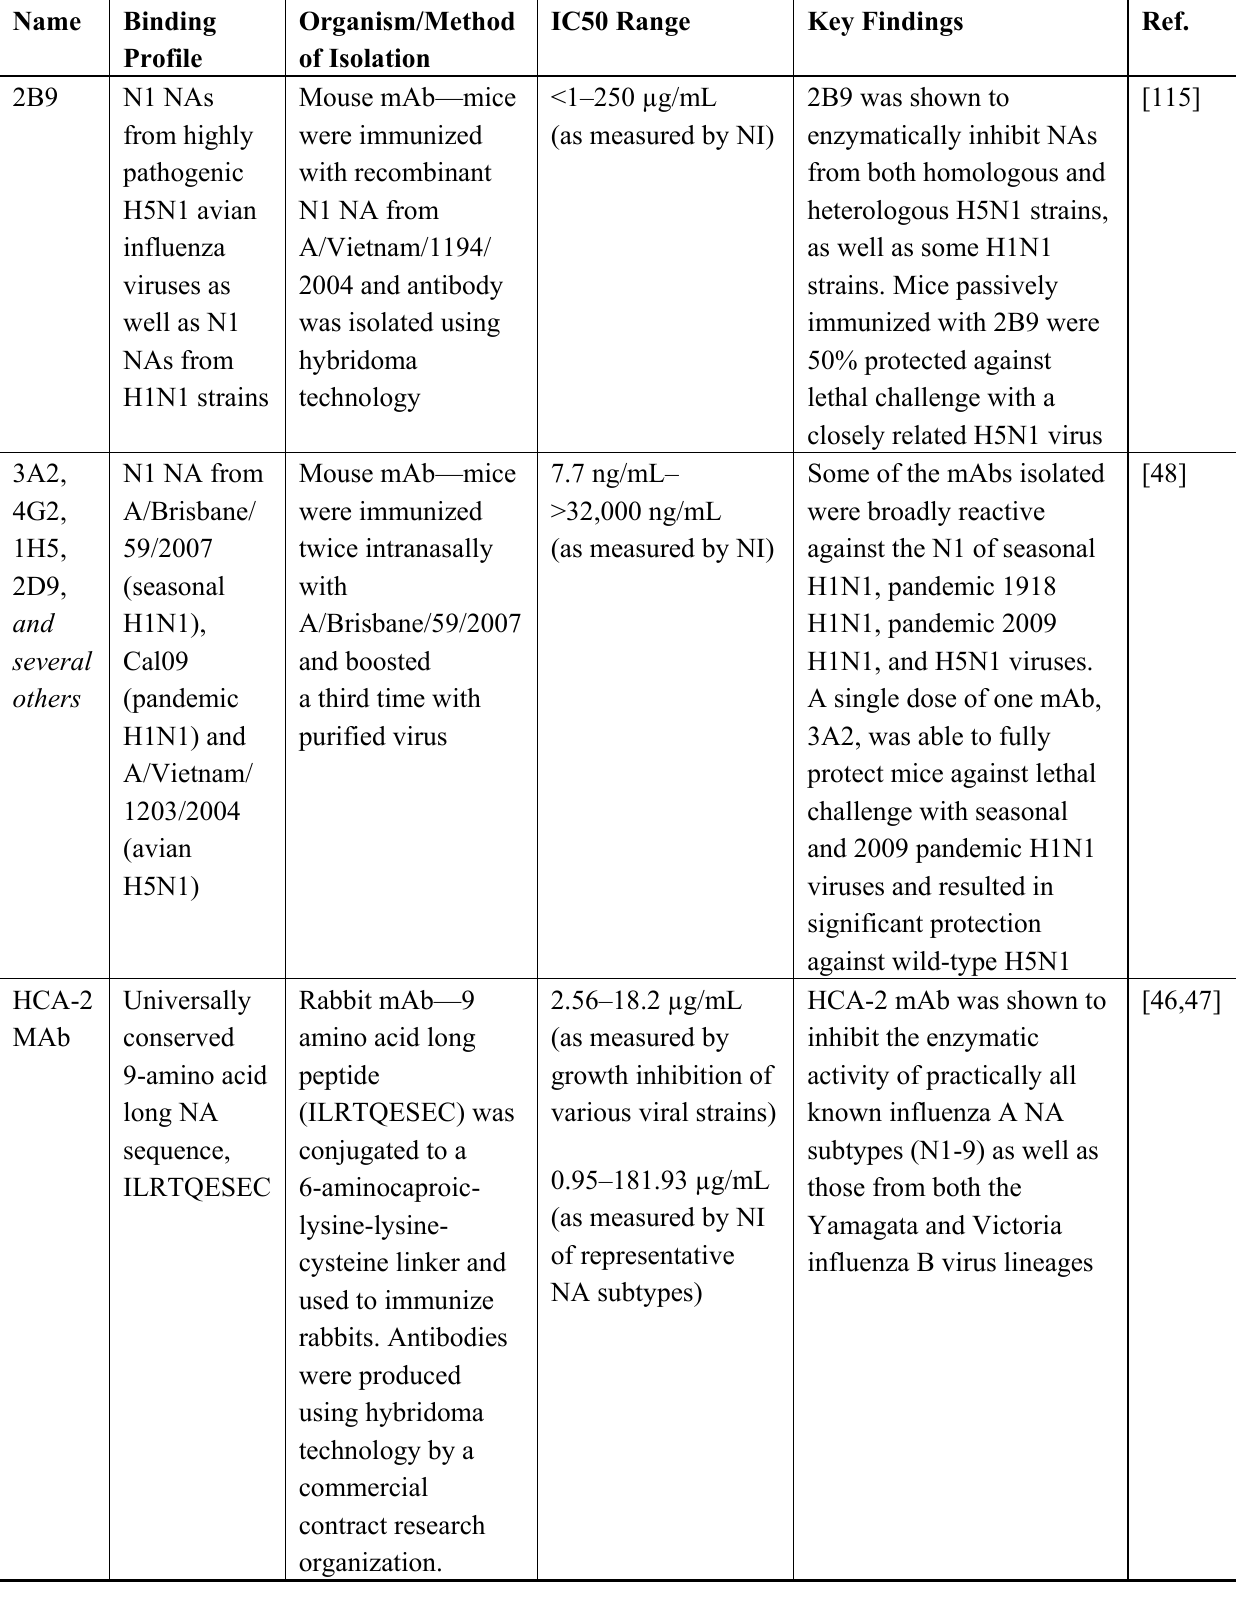
Table 2. Isolated anti-NA monoclonal